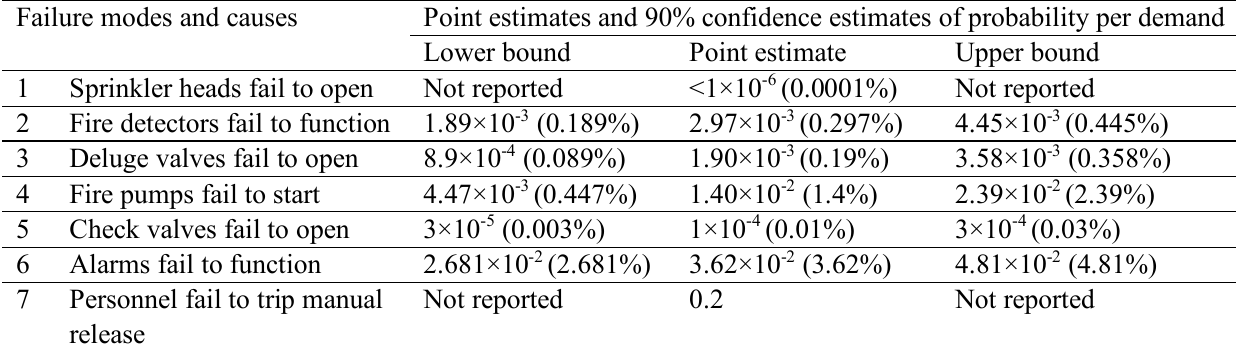
Table 2. Values and average of the failure rates of the components of the water sprinkler system Failure modes and